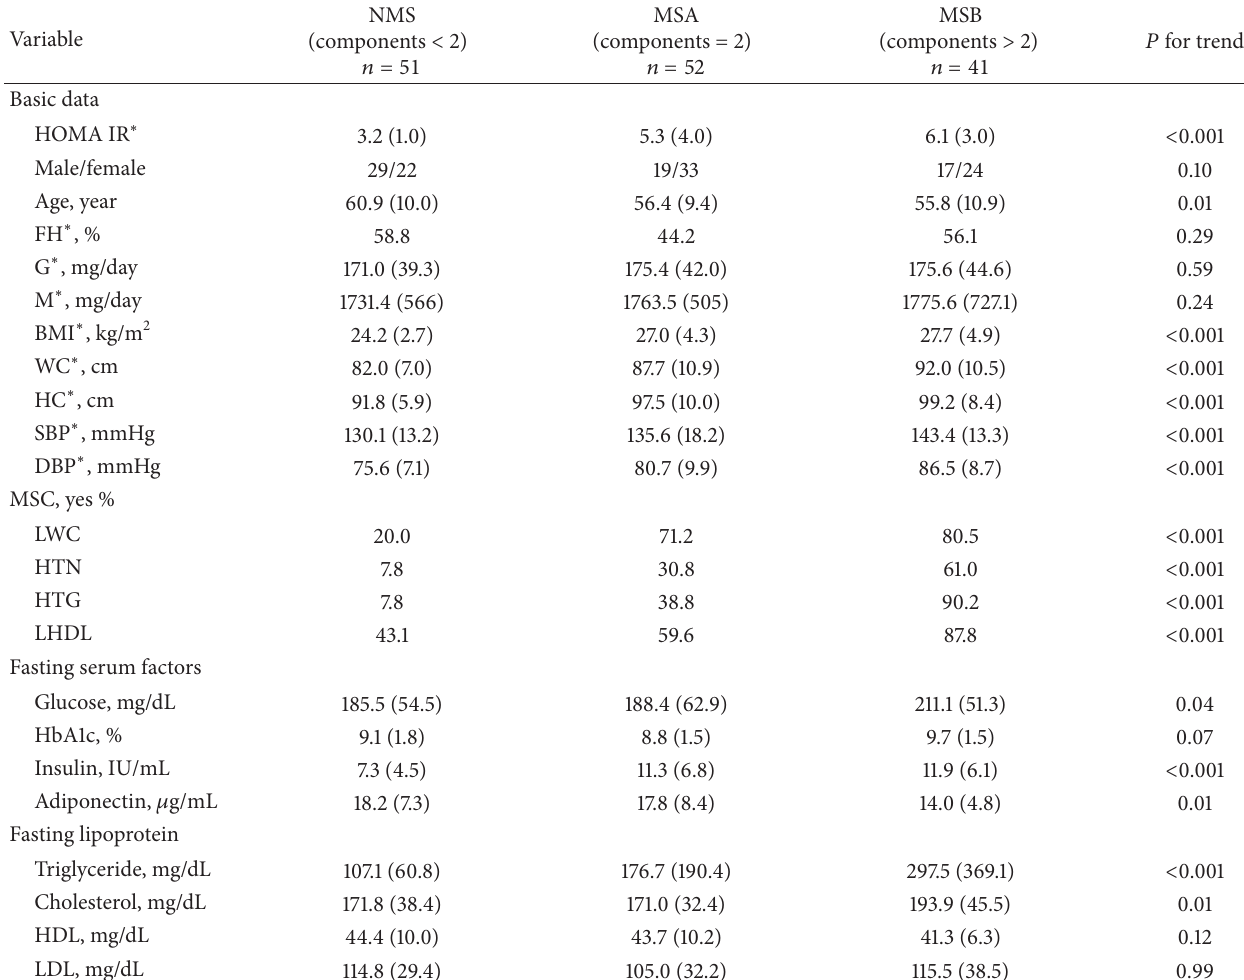
Table 2: Comparison of characteristics among the groups of nonmetabolic syndrome (NMS), metabolic syndrome A (MSA), and metabolic syndrome B